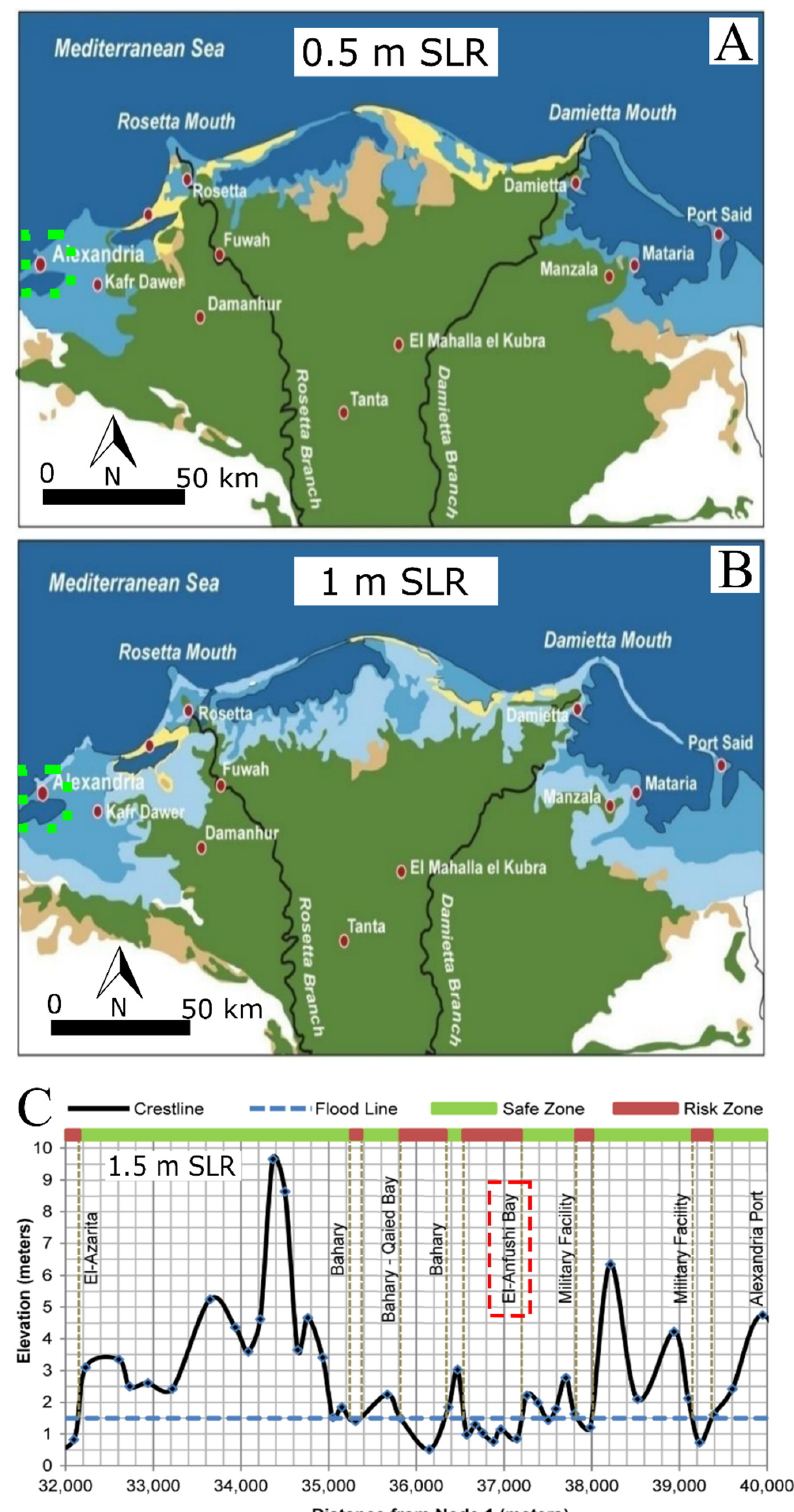
Figure 7. ( A , B ) Two scenarios for possible water increases of 0.5 m and 1 m, respectively, and their impact on territory. Alexandria and the research area are represented in the green dotted square, after [29]. ( C ) Longitudinal profile of the flood line and safe and risk zones for the SLR scenario of 1.5 m. The study area is represented in black rectangle as a risk zone, after [28].